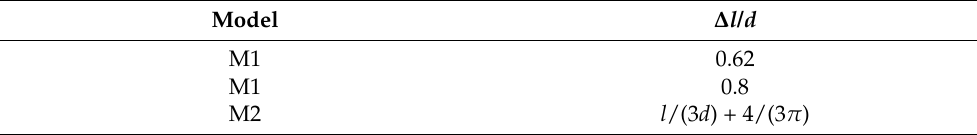
Table 3. ∆ l/d ratio in the Helmholtz resonance frequency